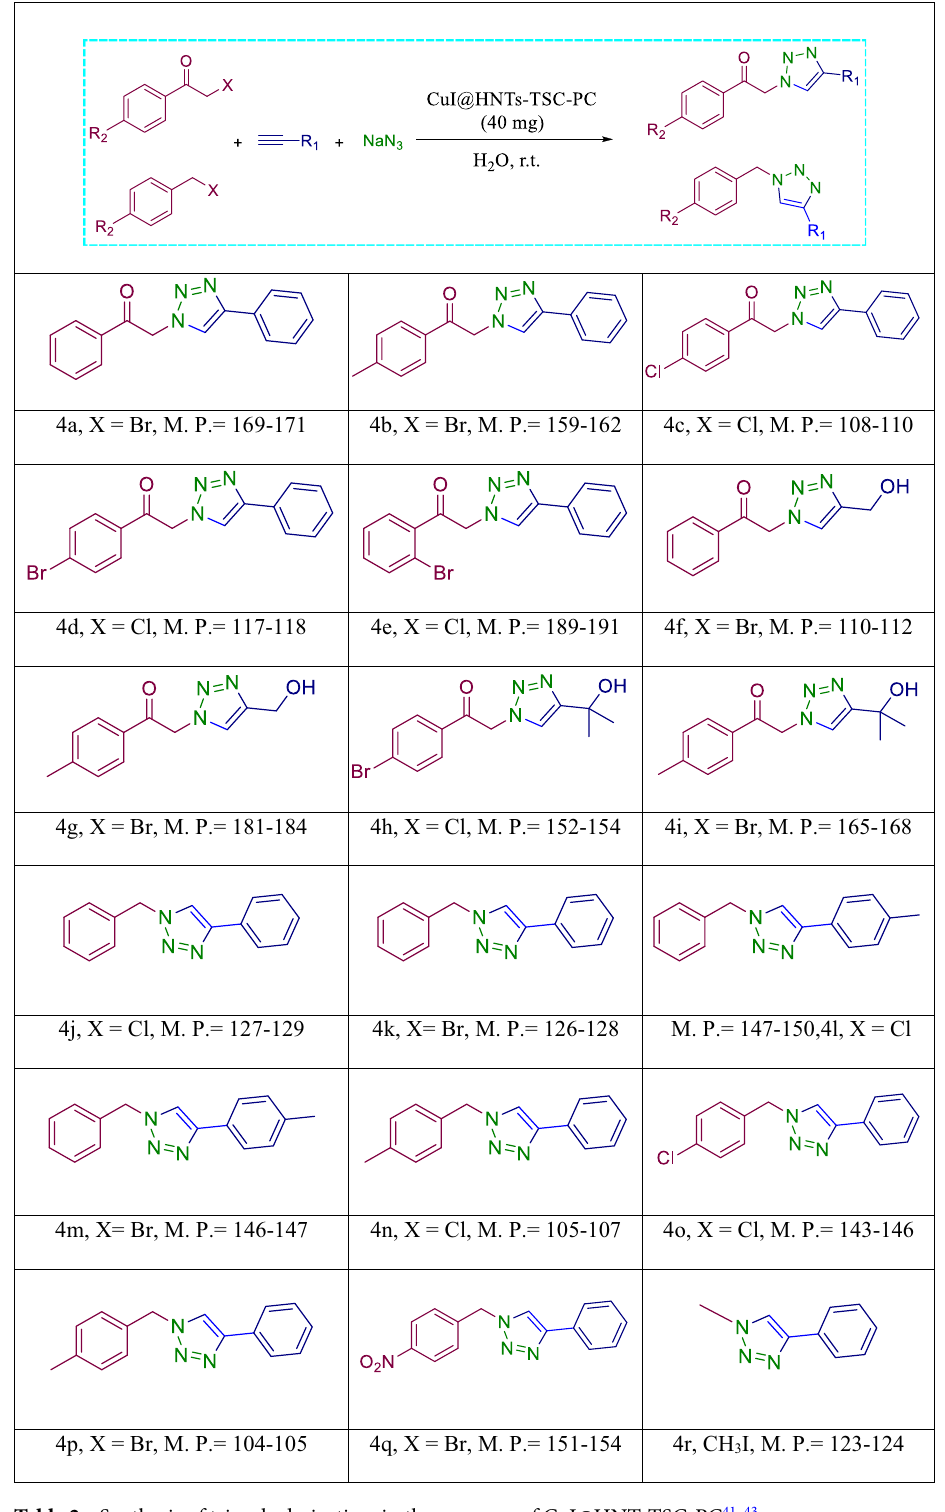
Table 2. Synthesis of triazole derivatives in the presence of CuI@HNT-TSC-PC 41–43